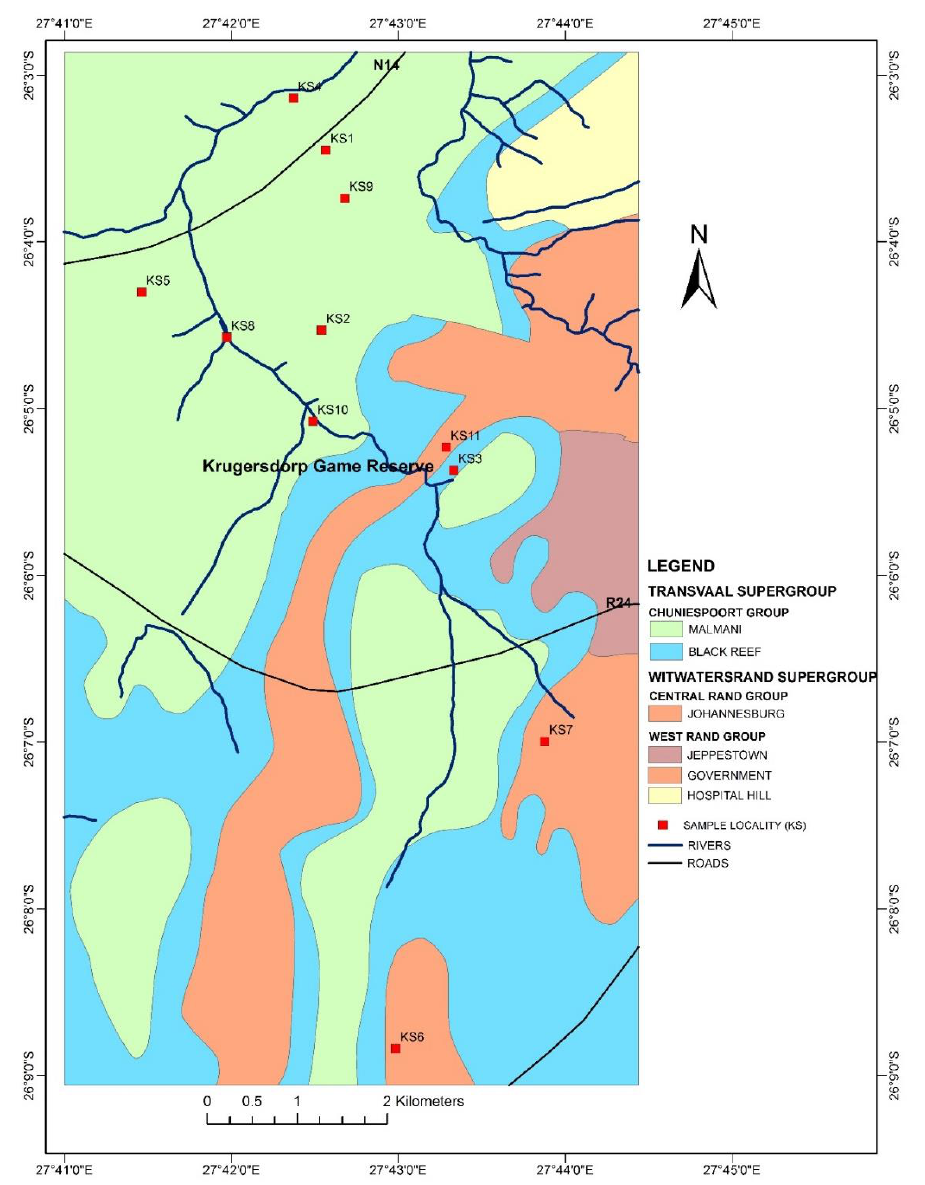
Figure 2. Geology and soil sampling points. KS = soil sampling points.